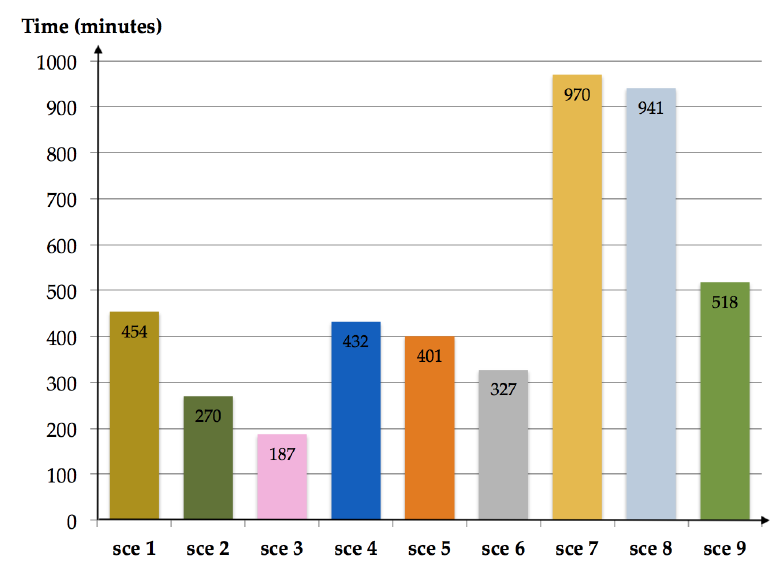
Figure 23. Execution time in seconds for Scenarios 1 to 9.